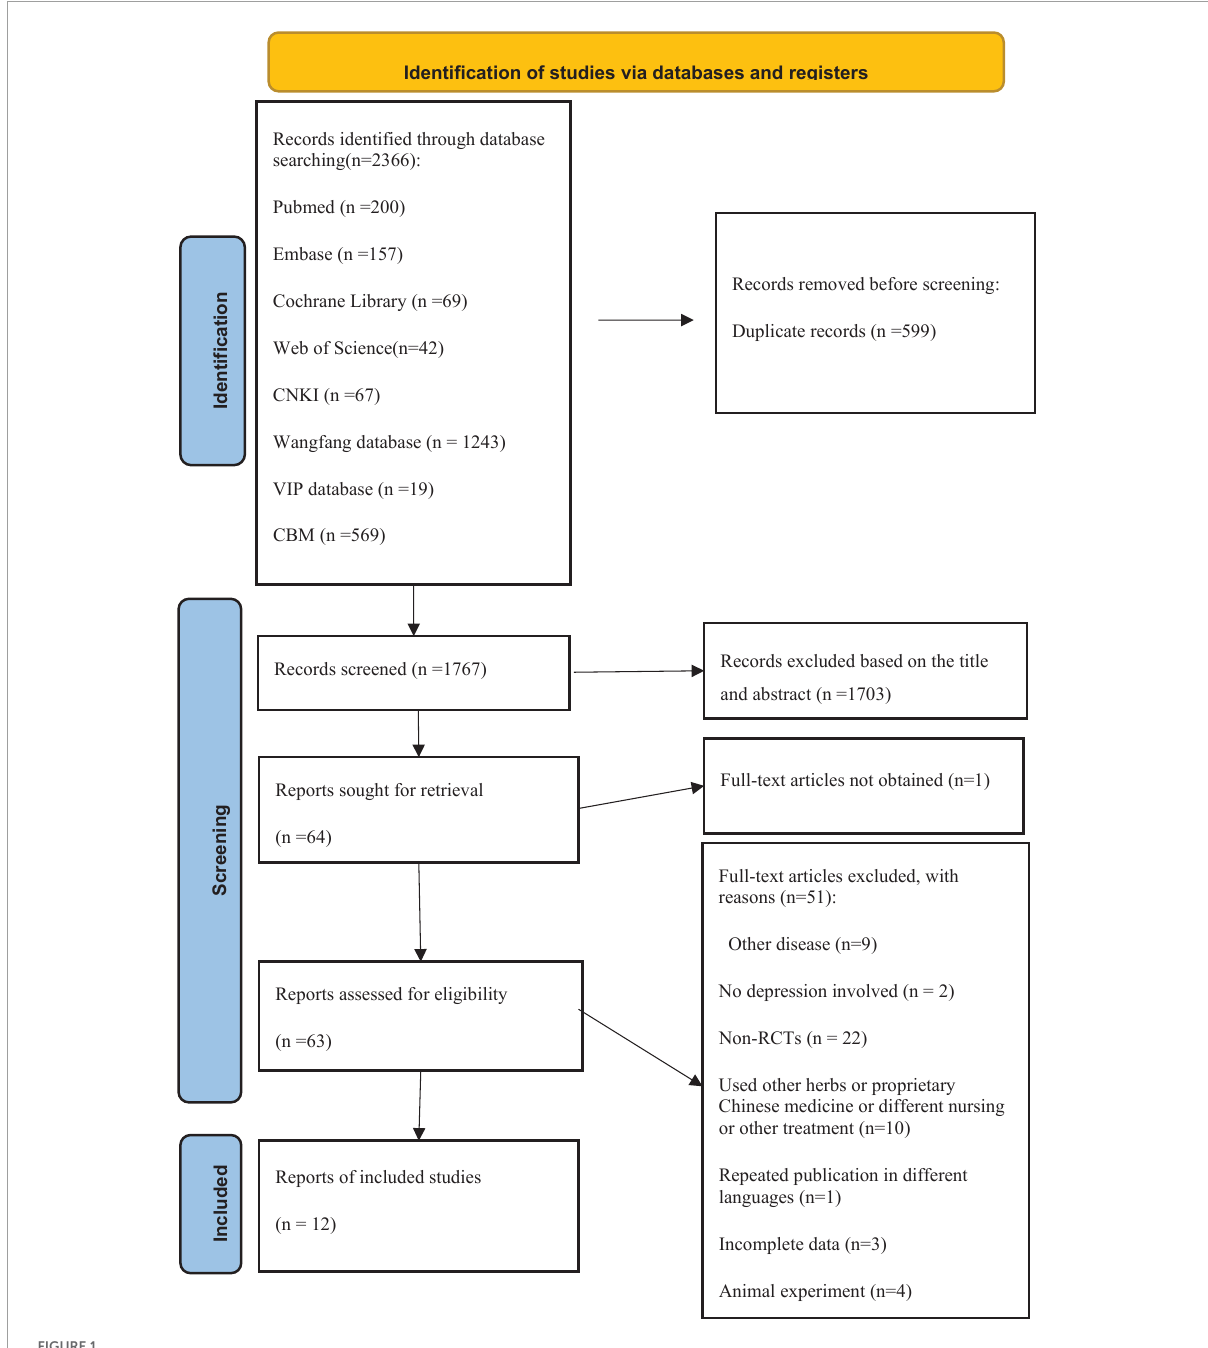
FIGURE1 Flow chart of the study selection